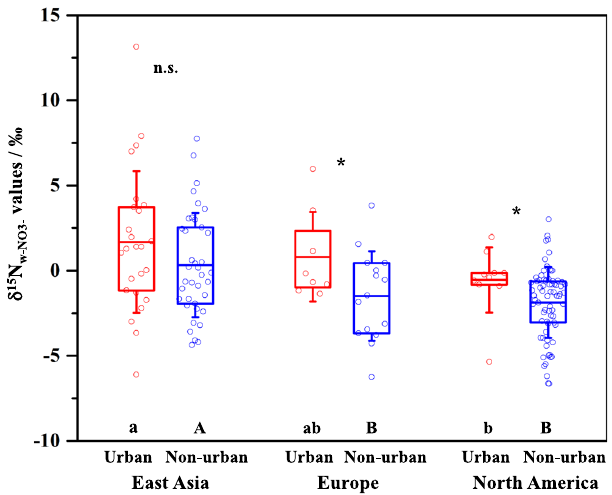
Fig. 2 δ 15 N w-NO3 − values at urban and non-urban sites of East Asia ( n = 25 and n = 38, respectively), Europe ( n = 8 and n = 15, respectively), and North America ( n = 10 and n = 73, respectively). Dots show mean values of replicate measurements at each site. The box encompasses the 25th − 75th percentiles, whiskers, and line in each box are the SD and mean values, respectively. The symbol of * indicates differences between urban and non-urban sites. n.s.: not signi fi cant. Different letters indicate differences among East Asia, Europe, and North America. The signi fi cance level was set at P <